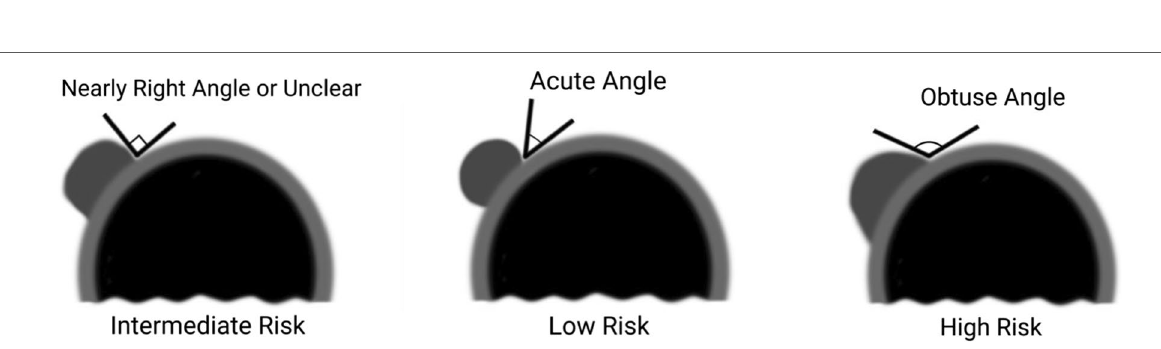
Fig. 9 Diagram representing risk classification of tracheal invasion by PTC based on angle of contact between the tumor and the tracheal cartilage (Figure adapted from Miyauchi A. Clinical Trials of Active Surveillance of Papillary Microcarcinoma of the Thyroid. World J Surg. 2016 Mar;40(3):516– 22. https:// doi. org/ 10. 1007/ s00268- 015-